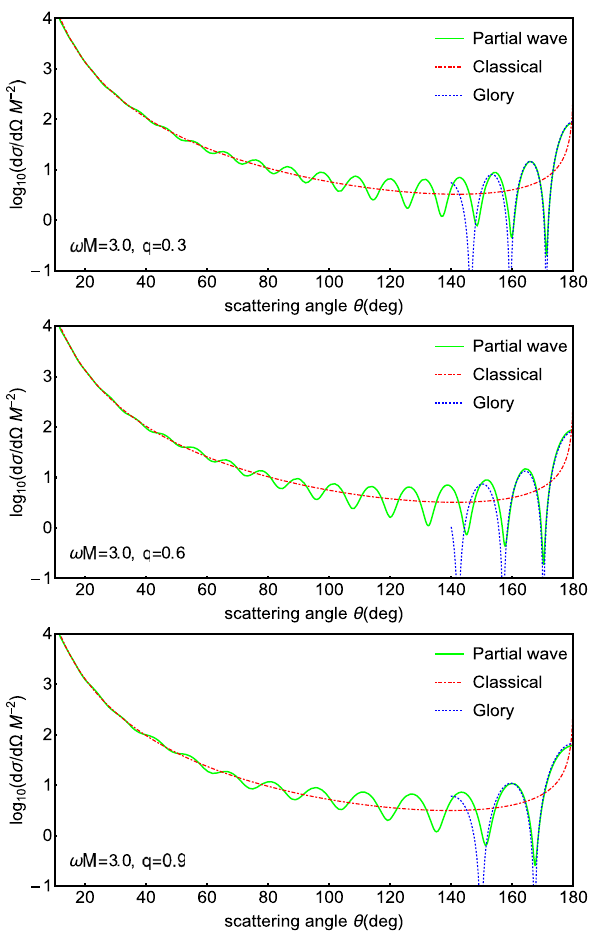
Fig. 5 Comparison of scattering cross sections with the geodesic and glory approximations for q = 0 . 3 (top), 0.6 (middle), and 0.9 (bottom). We set ω M = 3 . 0